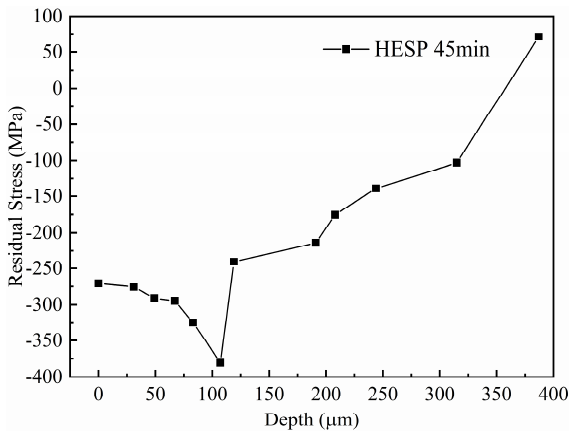
Figure 6. Residual stress profile of the HESPed in different depth.